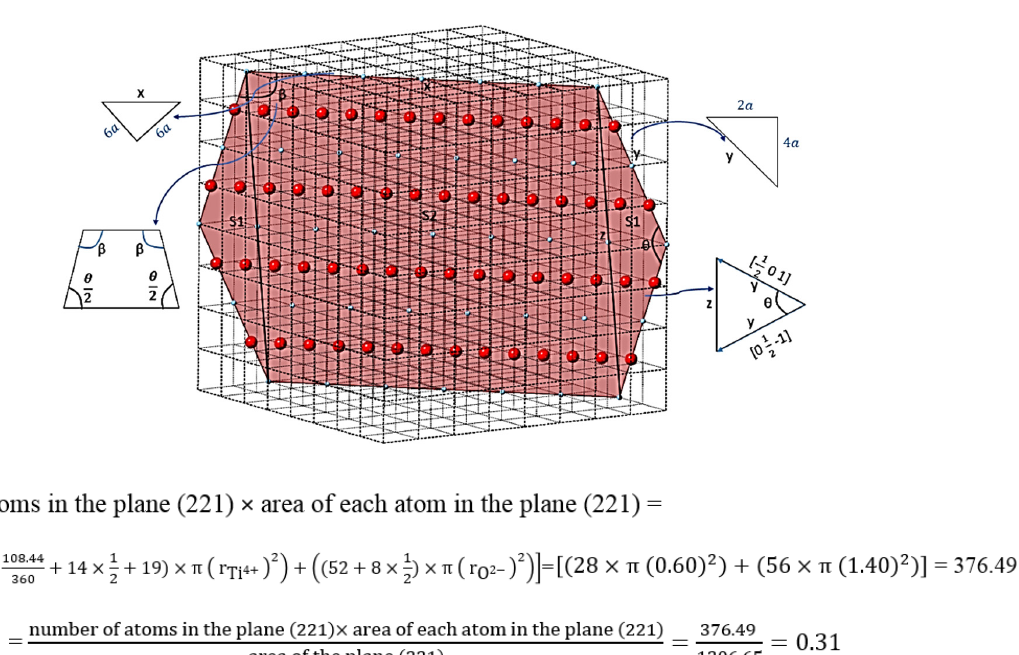
Figure 4. Geometry of planes and calculations of planar density of ( a ) (221) super cell (4 × 4 × 4) and ( b ) (221) super cell (8 × 8 × 8) (which shows and emphasizes the symmetry of (8 × 8 × 8) super cells).